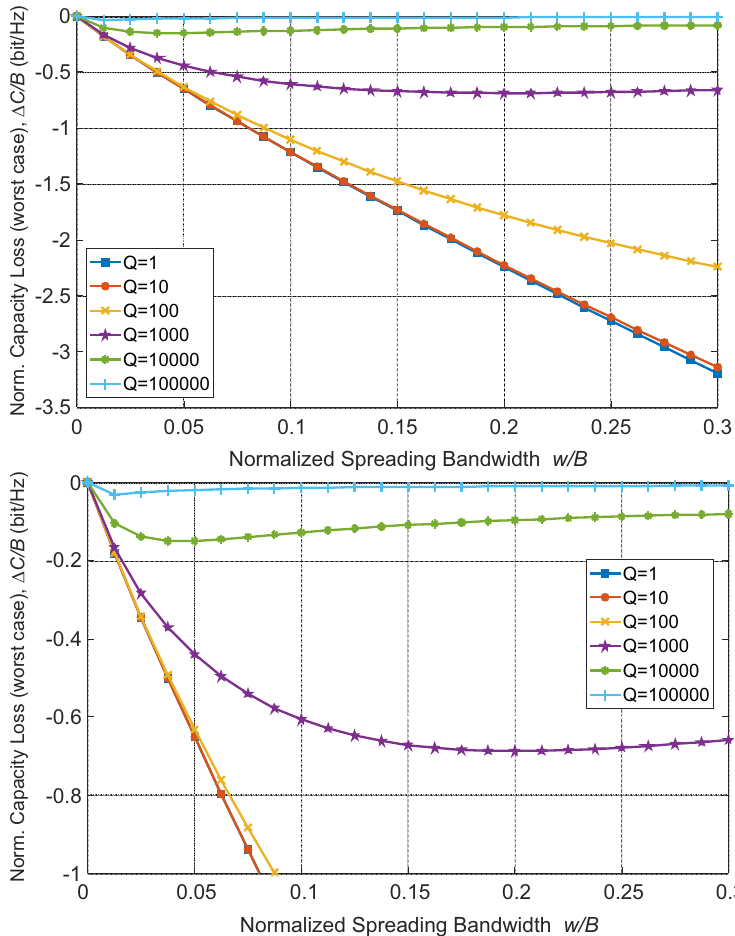
Figure 6. Worst case normalized capacity loss over different resonant frequencies f R versus SS-modulation depth δ ranging from 0 (no SS) to 30% for different values of the resonant coupling quality factor Q under constant peak coupling. A detail of the top figure is reported in the bottom